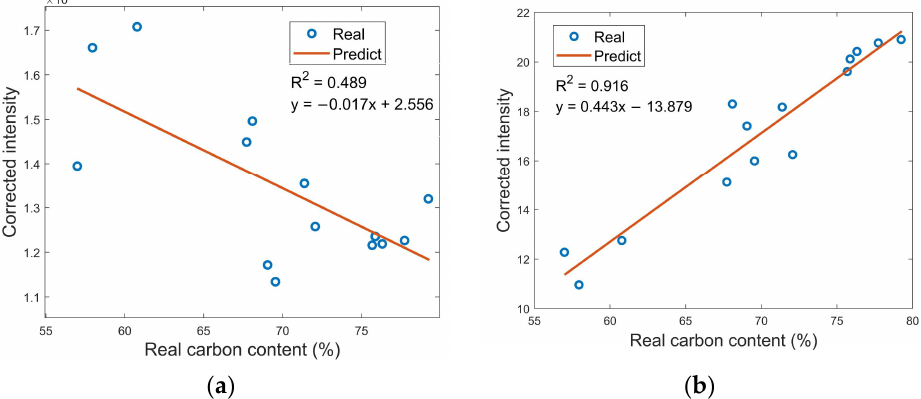
Figure 8. Plot of the fitting effect of C247.840 nm after P-airPLS method. ( a ) The goodness of fit for original data; ( b ) goodness of fit for processed data.